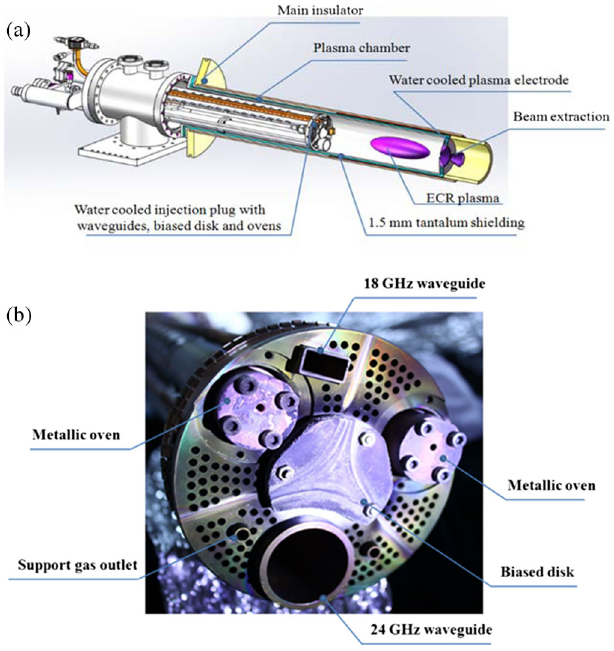
FIG. 4. The SECRAL source with 24 GHz microwave